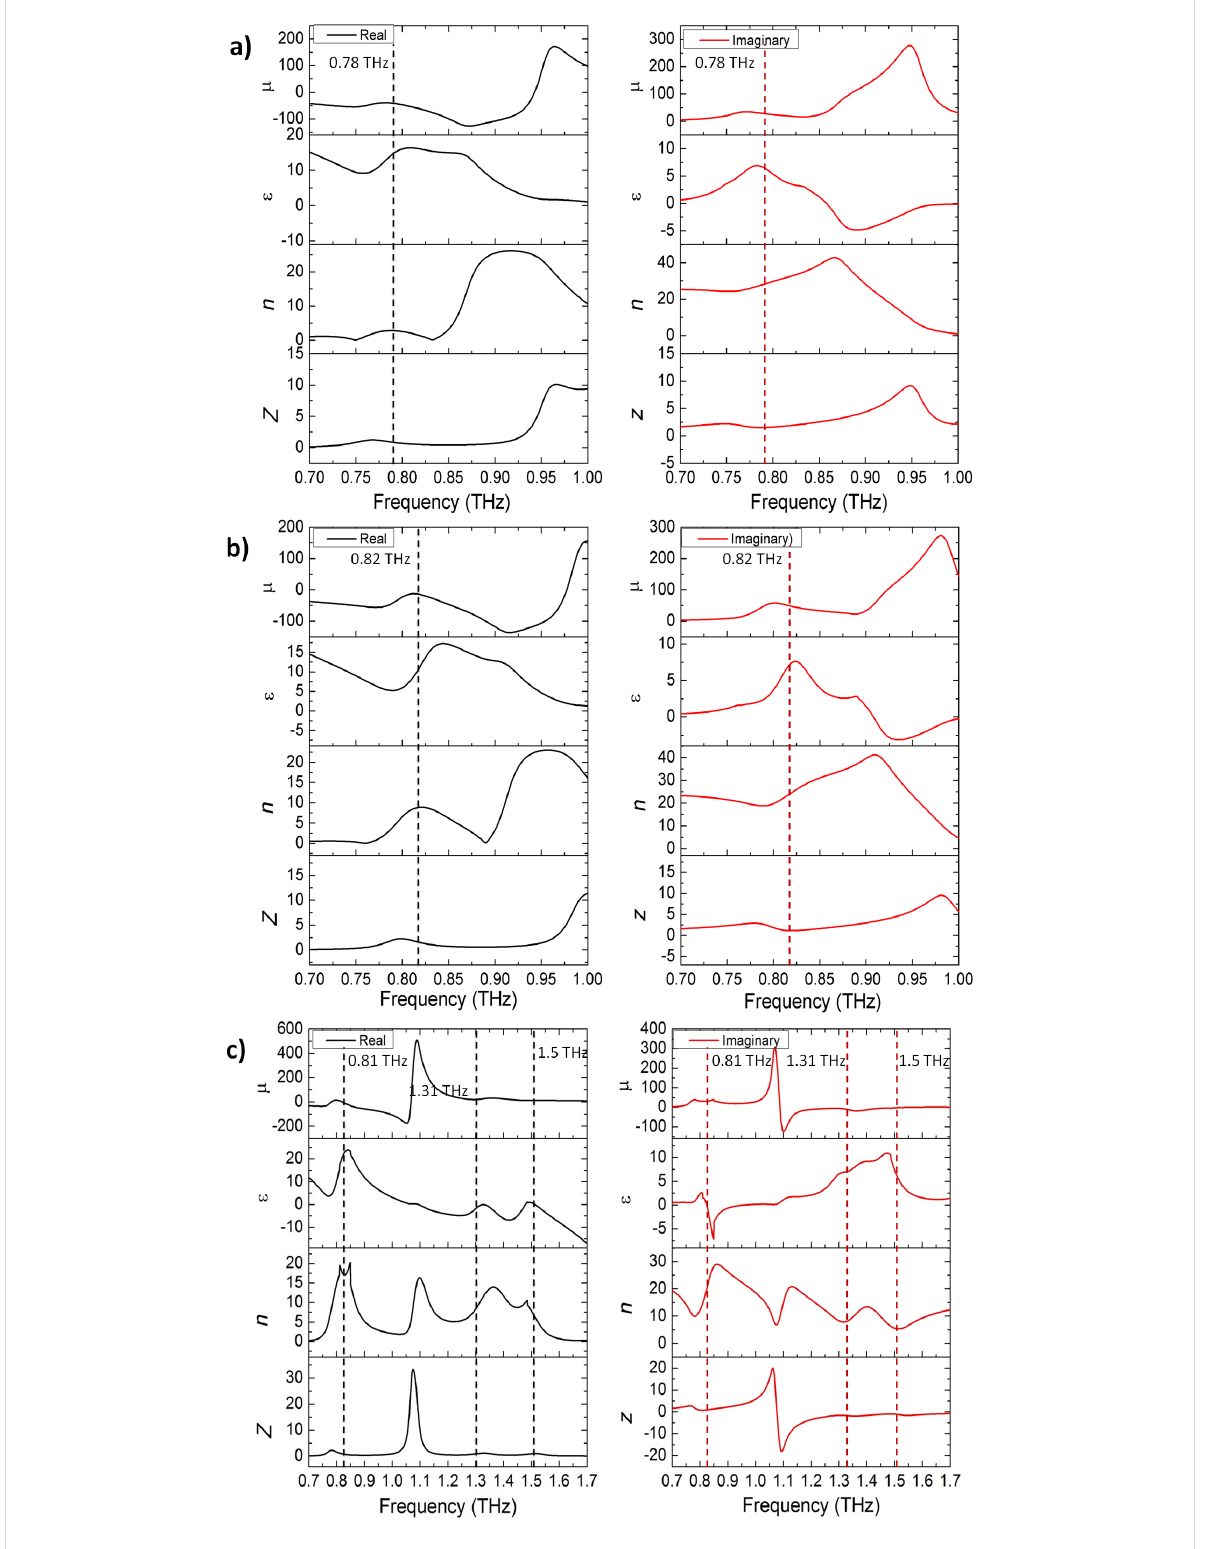
Figure 5: Permeability (µ), permittivity ( ε ), refractive index ( n ), and impedance ( Z ) properties of: a) Cut-wire sandwich structure, b) cross-shaped sandwich structure, and c) star-shaped sandwich structure. The black and red curves represent the real and imaginary part of each value, respective-